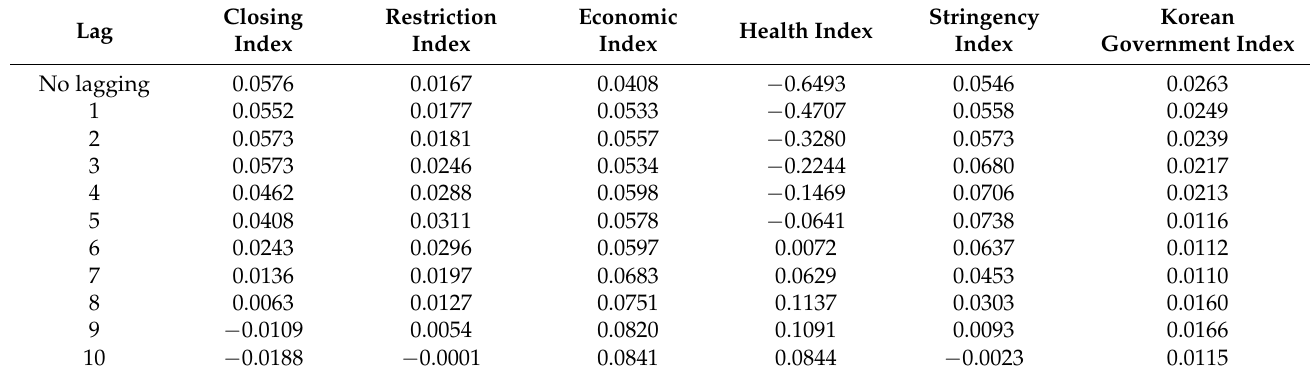
Table 5. Non-Seoul Metropolitan Area’s Coefficients from Single Index